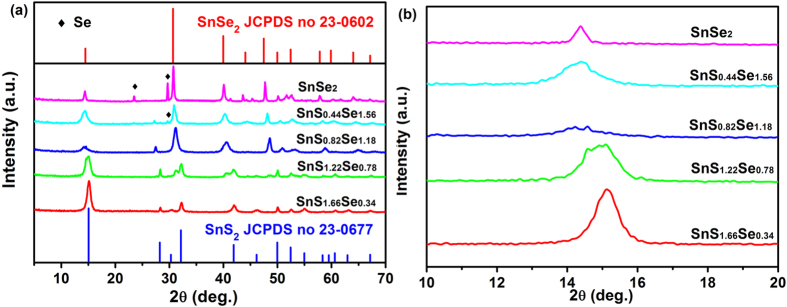
(a) XRD patterns of SnS2−xSex alloys with different Se contents. (b) Enlarged patterns of (a) from 10 to 20 degrees of SnS2−xSex alloys.